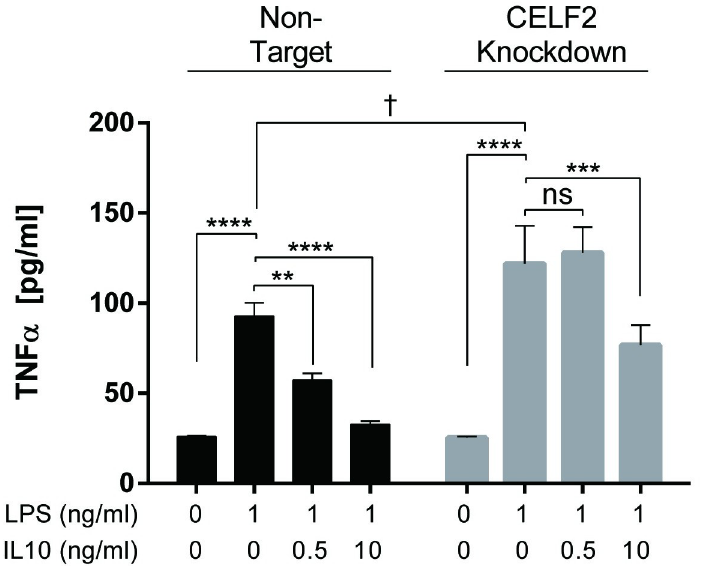
Fig 5. Knockdown of CELF2 impairs IL10 inhibition of TNF α expression. RAW264.7/Cas9 cells transduced with CELF2 sgRNA or non-target sgRNA were treated with 2 μ g/ml doxycycline to induce knockdown of CELF2 protein. CELF2 or non-target knockdown cells were stimulated with 1 ng/ml LPS ± indicated concentration of IL10 for 1 hour prior to collecting the supernatant. The level of TNF α was determined by ELISA. (Two-Way ANOVA with Tukey’s correction. The asterisk ( � ) were used for comparison within the same cell type and the dagger (†) were used for comparison between the different cell types, ���� p < 0.0001, ��� p < 0.001, �� p < 0.01, � p < 0.05, † p < 0.05).